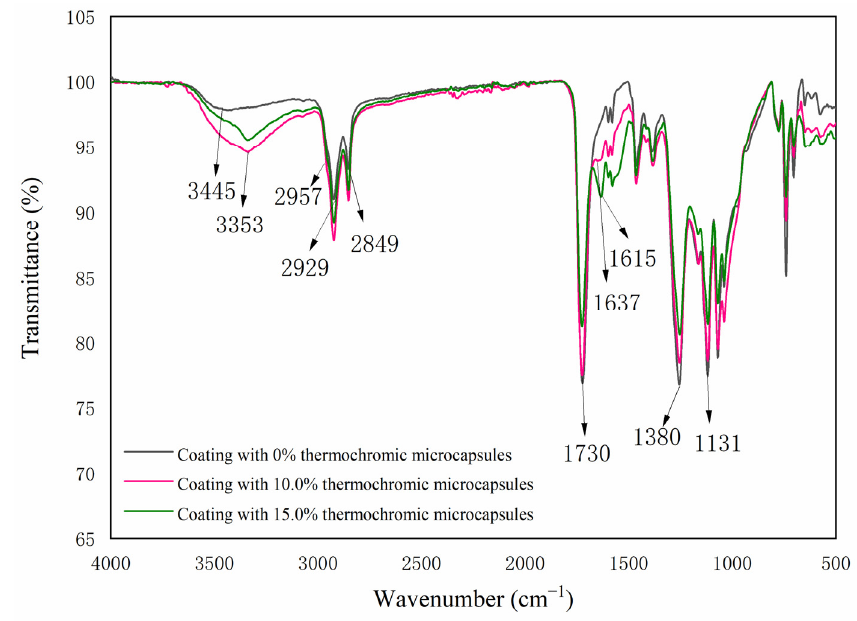
Figure 8. FTIR spectra of coatings with different microcapsule contents.